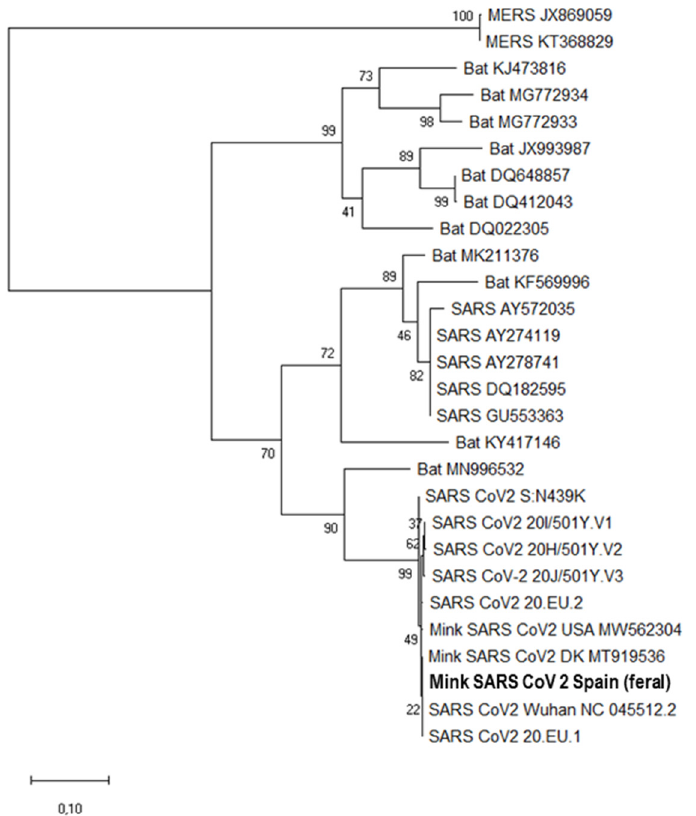
Figure 3. Molecular phylogenetic analysis using the sequence of a 397-nucleotide fragment of the SARS CoV-2 S gene (consensus genome coordinates, nt 22,728–23,124). The evolutionary history was inferred by the maximum likelihood method based on the Tamura–Nei model. The tree with the highest log likelihood ( − 2888) is shown. The percentage of trees in which the associated taxa